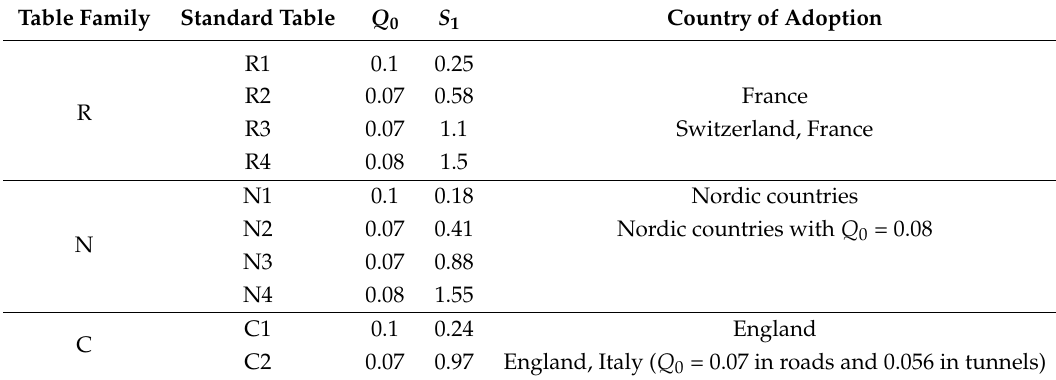
Table 1. CIE reference data of road surfaces for design calculations, type of road, countries of adoption as reference data for design calculation.